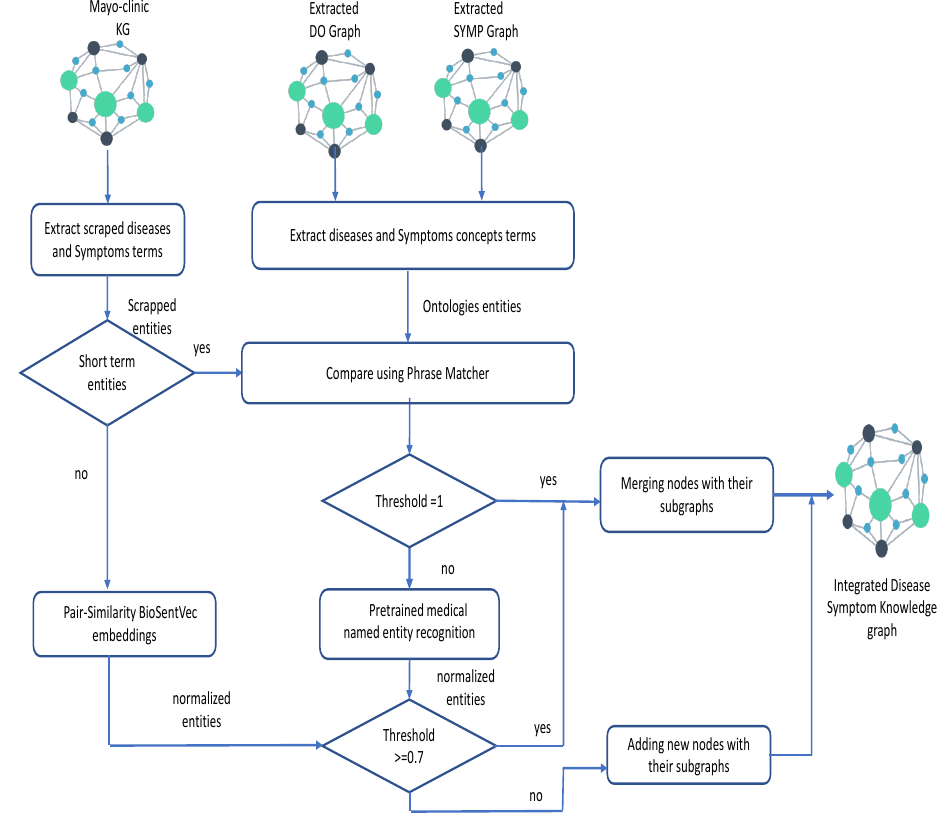
Figure 7. Entity linking and Integration